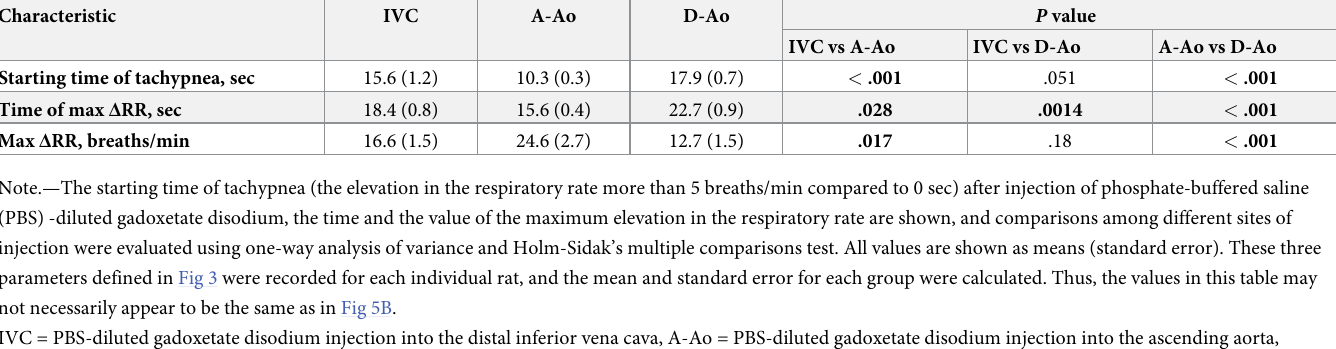
Table 4. Statistical analysis of time-series changes in the respiratory rate among different injection sites in rats. Characteristic